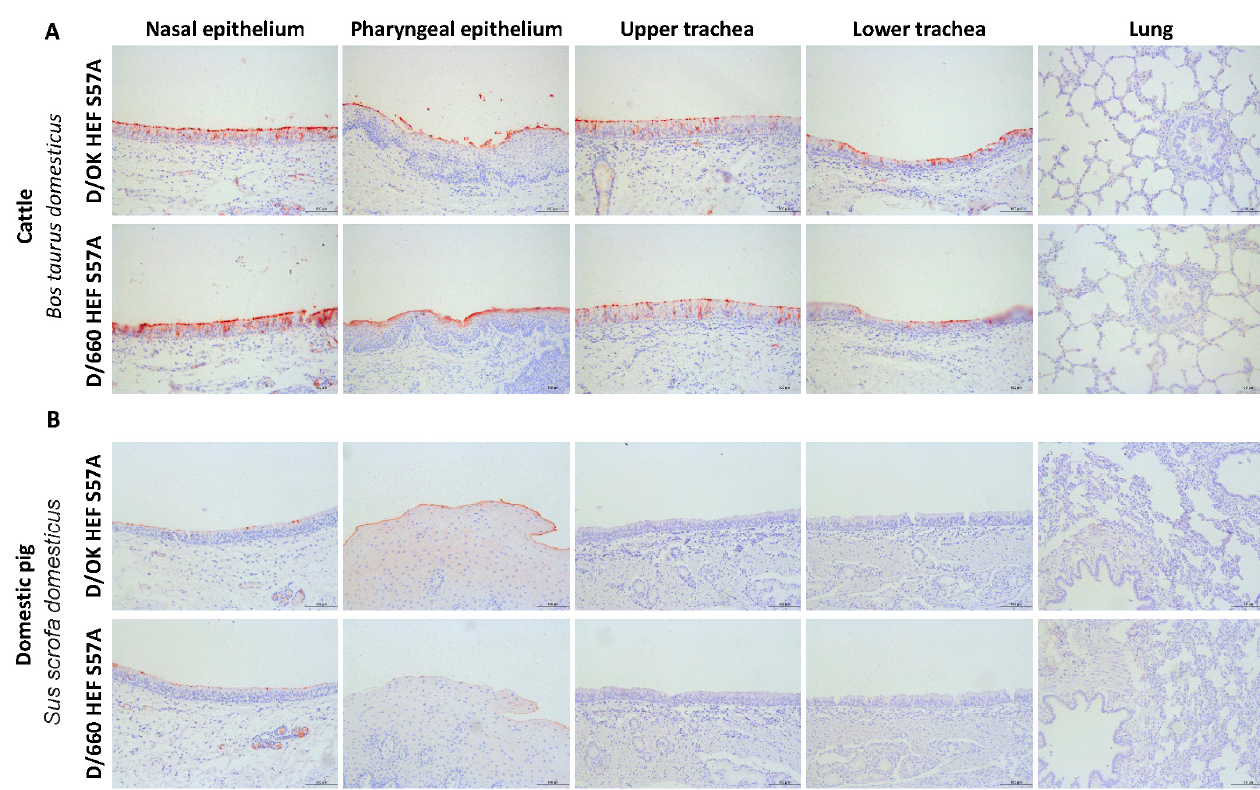
Figure 3. ( A ) Protein histochemical staining of tissue micro-array containing cattle (5 on array) respiratory tissues with D/OK and D/660 HEF S57A proteins at 50 µg/mL and ( B ) staining of tissue micro-array containing domestic pig (6 on array) respiratory tissues with D/OK and D/660 HEF S57A proteins at 50 µg/mL. Scale bars are 100 µm. Technical repeats were performed 3 times on both microarrays. See Supplementary Tables S1 and S2 for the content and arrangement of each microarray.